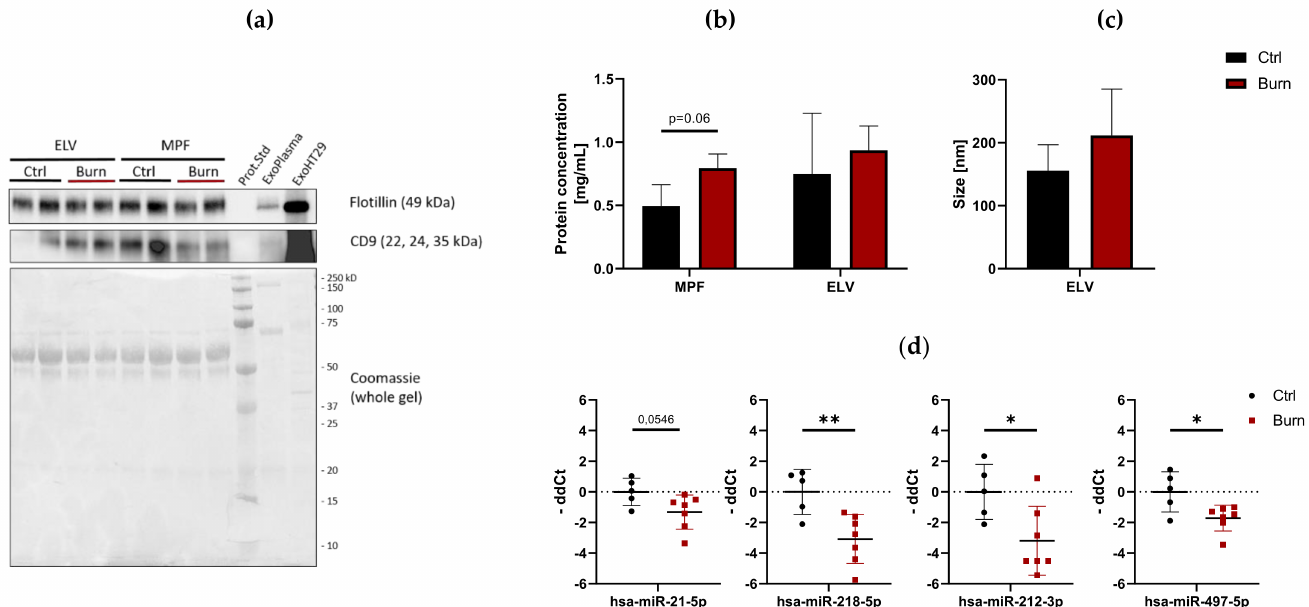
Figure 4. Characterization of dISF in an ex vivo human skin model for burn injuries. ( a ) Western blot for expression of exosomal markers flotillin and CD9. Coomassie staining of the whole gel is displayed as loading control. ( b ) Protein concentration in MPF and ELV and ( c ) mean size (nm) of particles in the ELV. ( d ) MiRNAs differentially expressed in dISF sampled with dOFM. Data are derived from 3 independent experiments and presented as individual values of -ddCt, normalized to an interplate calibrator and expressed relative to controls, with means (line) and standard deviation (whiskers). Significance was tested with Student ´ s t -test, followed by Bonferroni correction; p -values <0.05 were considered as statistically significant, with *, ** indicating p < 0.05, p <